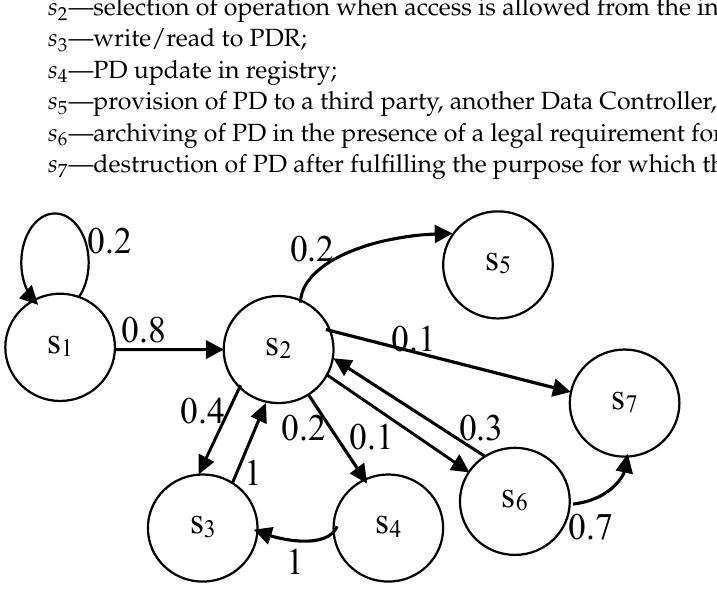
Figure 3. Markov model of traditional personal data processing (model “A”).